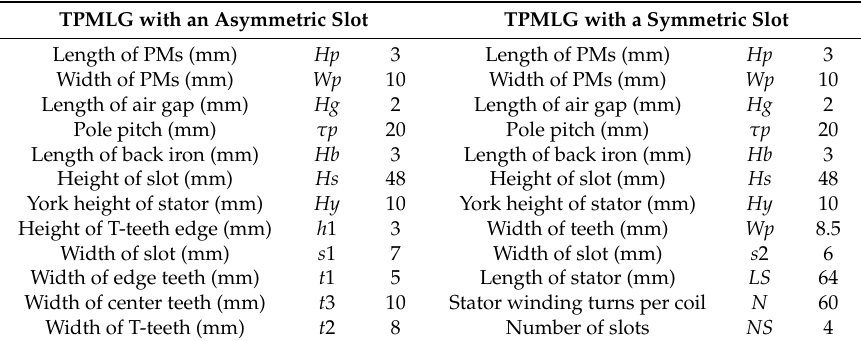
Table 2. Basic parameters of the TPMLGs with asymmetric and symmetric